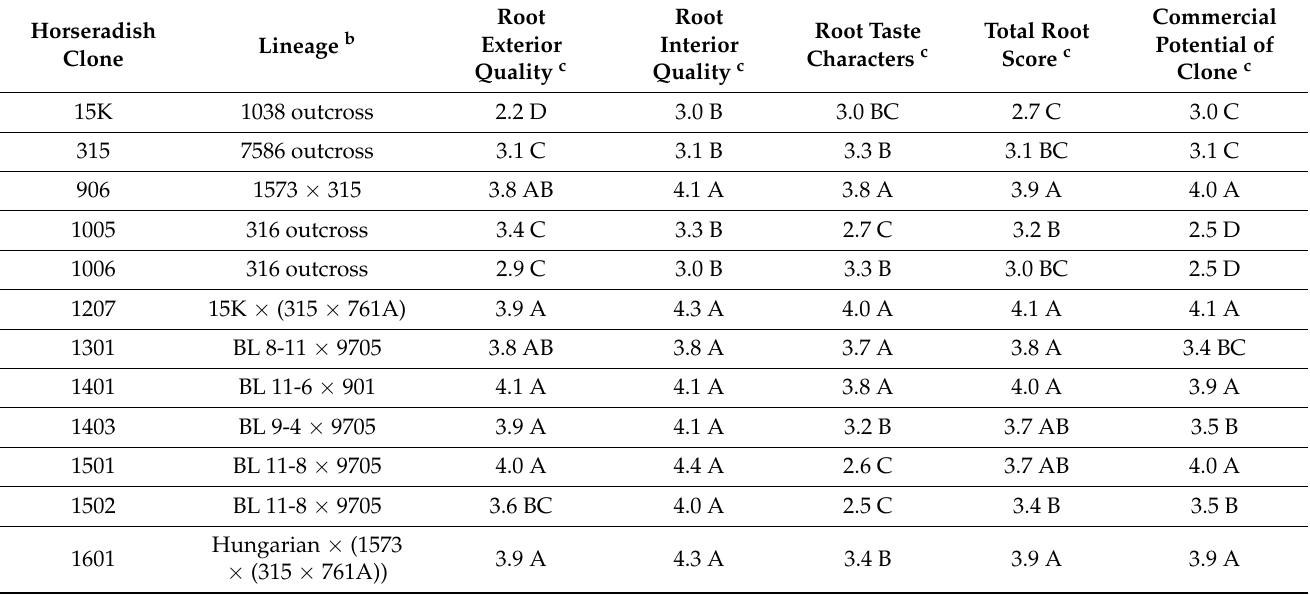
Table 2. Some horseradish clones released from the Illinois breeding program, describing specific exterior and interior quality characteristics and potential of clone for commercialization as rated by horseradish growers in Illinois, USA a .